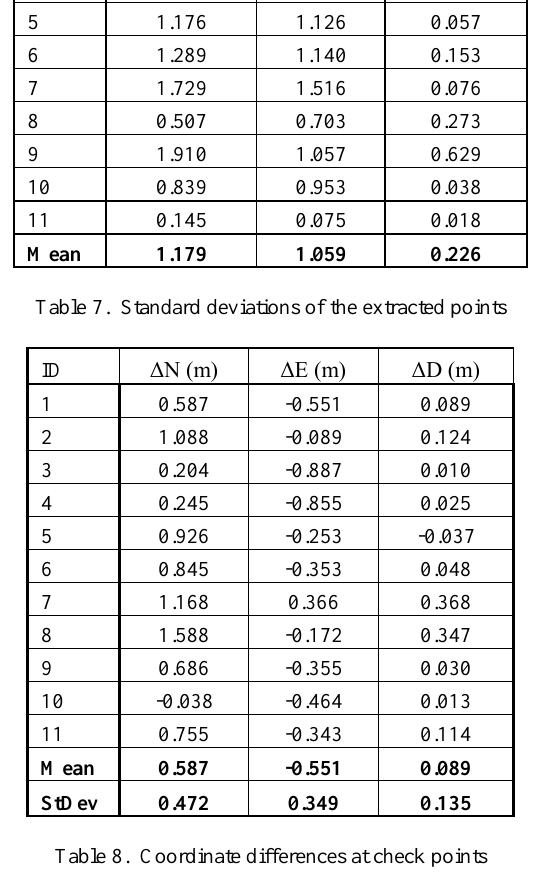
Table 8. Coordinate differences at check